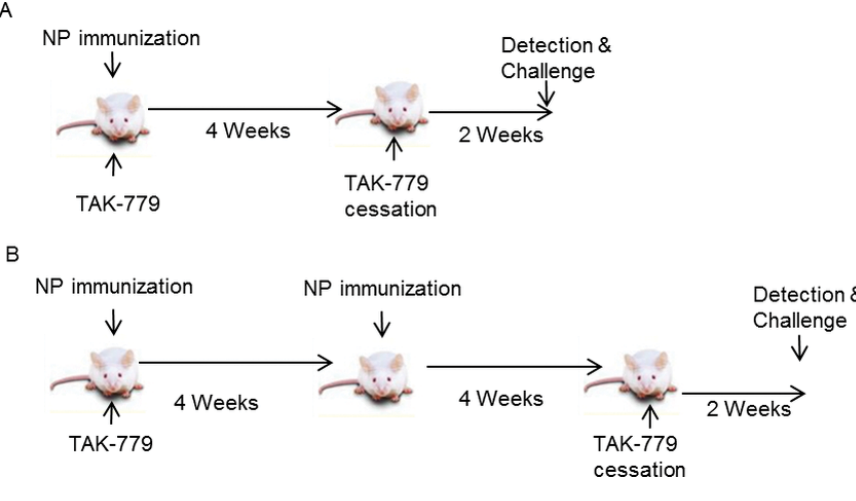
Figure 1. Mouse immunization and treatment schedules. The mice were immunized intra- peritoneally once or twice at a 4 wk interval with 40 μ g NP protein emulsified with Freund’s incomplete adjuvant (IFA). TAK-779 administration was started from d 0 after immunization and continued once daily for 4 wks or 8 wks for 1 or 2 immunizations, respectively. For influenza virus infection, 2 wks after stopping TAK-779, sedated mice received intranasal (i.n.) administration with 10 50% lethal doses (LD50) of H1N1